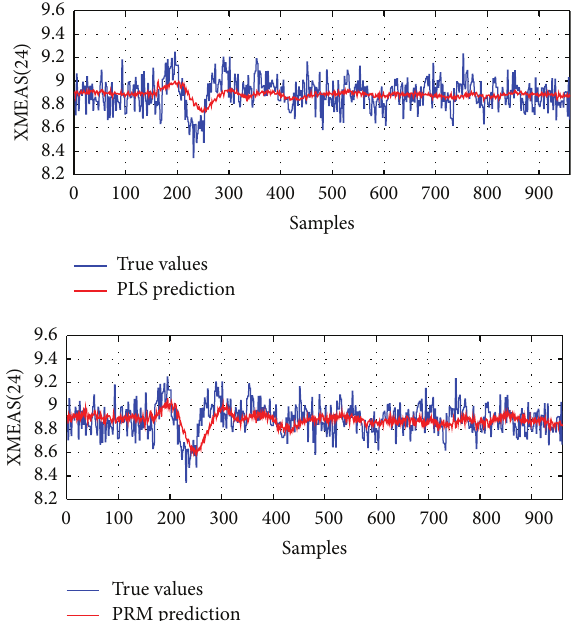
Figure 2: Quality-related indicator prediction using PLS and PRM with no outliers.